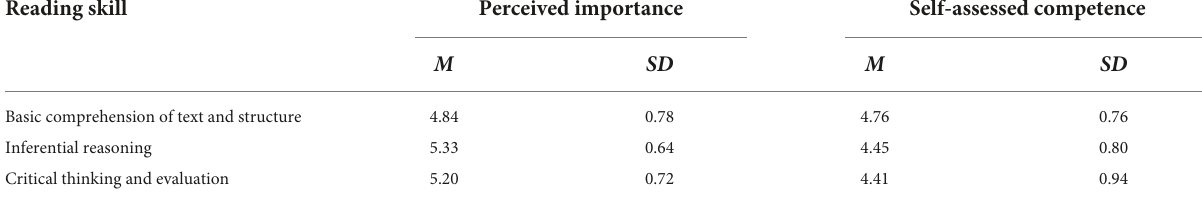
TABLE 2 Means and standard deviations of three reading skills from reading questionnaire ( n = 34). Reading